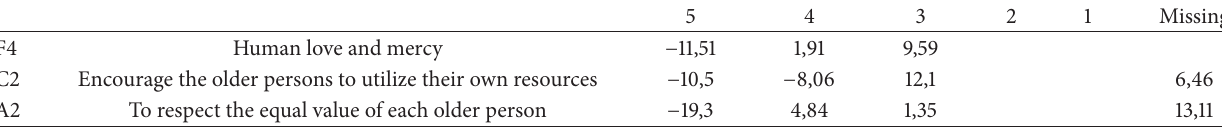
Table 2: Effects on distribution function when E4 fixed to “4” = 100%.